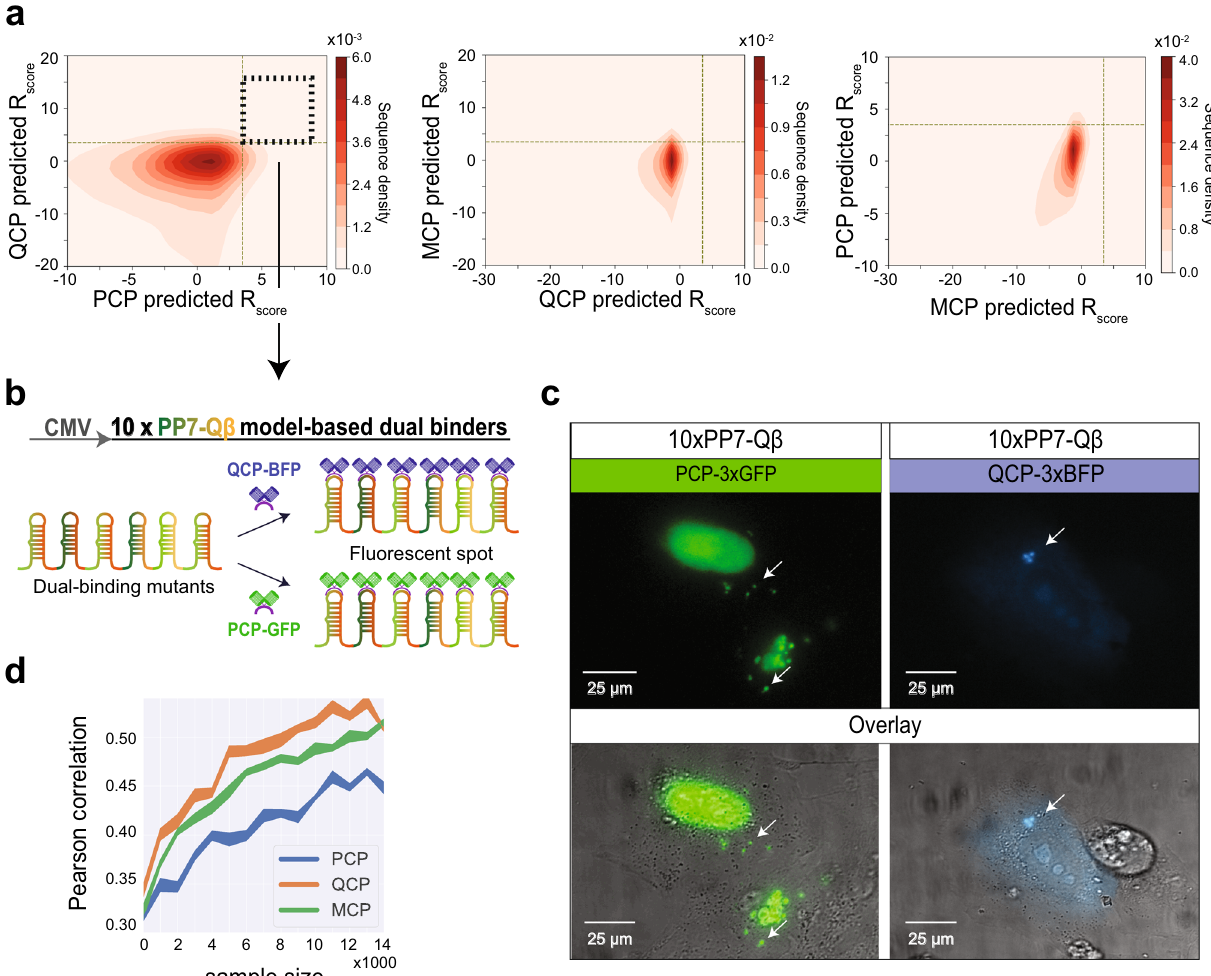
Fig. 6 De novo design of dual-binding site cassettes in U2OS cells. a 2D density plots (pink-red scale) depicting the predicted R score values for one million ML variants binding to (left-to-right): PCP and QCP, MCP and QCP, and MCP and PCP. QCP-PCP dual-binding variants are located in the black dashed square. b Based on the dual-binding mutants for QCP and PCP from our model predictions, we designed an additional cassette. c Results for the dual- binding experiment. Fluorescent foci can be observed for the cassette expressed with either PCP-3xGFP or QCP-3xBFP. For both experiments, both the relevant fl uorescent channel and the merged images with the DIC channel are presented. Each of the two experiments were successfully conducted in duplicates and on two different days. Fluorescent wavelengths used in these experiments are: 400 nm for BFP and 490 nm for GFP. d Evaluation of prediction accuracy based on size of the training set. For each training set size, a random set of more than 1,000 training-set variants was withheld for computational testing post-training. Performance is reported as average Pearson correlation over 10 random training and test sets (and standard deviation in shade). Source data are provided as a Source data fi